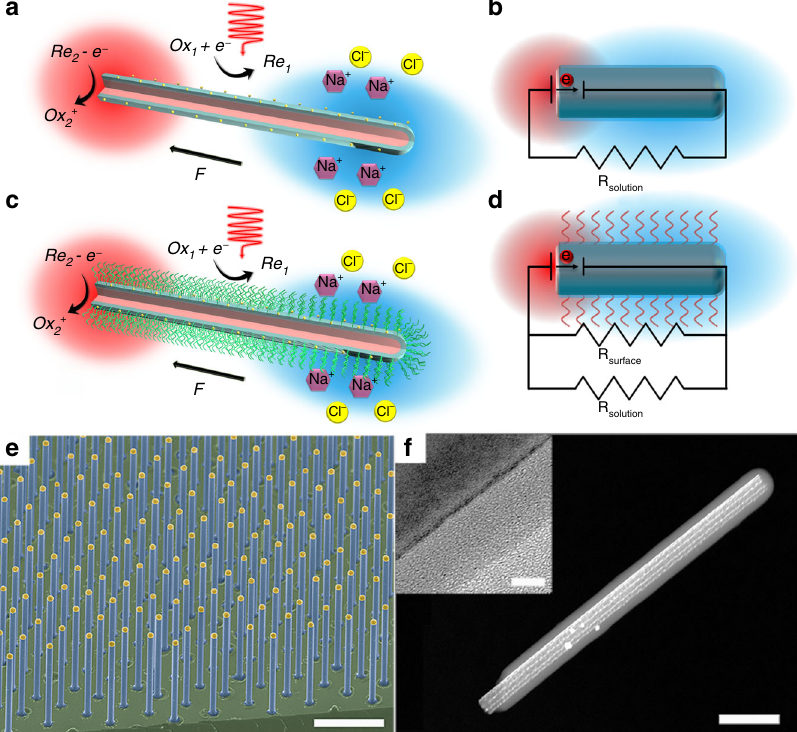
Fig. 1 Schematic diagram and structural characterization of microswimmers. a , c Schematic diagram of silicon nanowire microswimmer without and with polyelectrolyte coating. The SPS layer was chemically grafted onto the core – shell silicon nanowire. Upon illumination, the surface electrochemical reaction driven by the nanowire solar cell produces OH − and H + ions on the n-type silicon shell and exposed p-type silicon core, respectively. The electric fi eld built by the unbalanced ions propel the negatively charged nanowire. b , d The equivalent circuits of nanowire microswimmer operation without and with polyelectrolyte coating. e False-colored scanning electron microscopy image of silicon nanowire array grown by the VLS method. f Scanning transmission electron microscopy (STEM) image of SPS-grafted silicon nanowire. Inset is high-resolution TEM image of SPS-modi fi ed silicon nanowire. (Scale bars in e , f , and f inset are 10 μ m, 200 nm, and 5 nm,